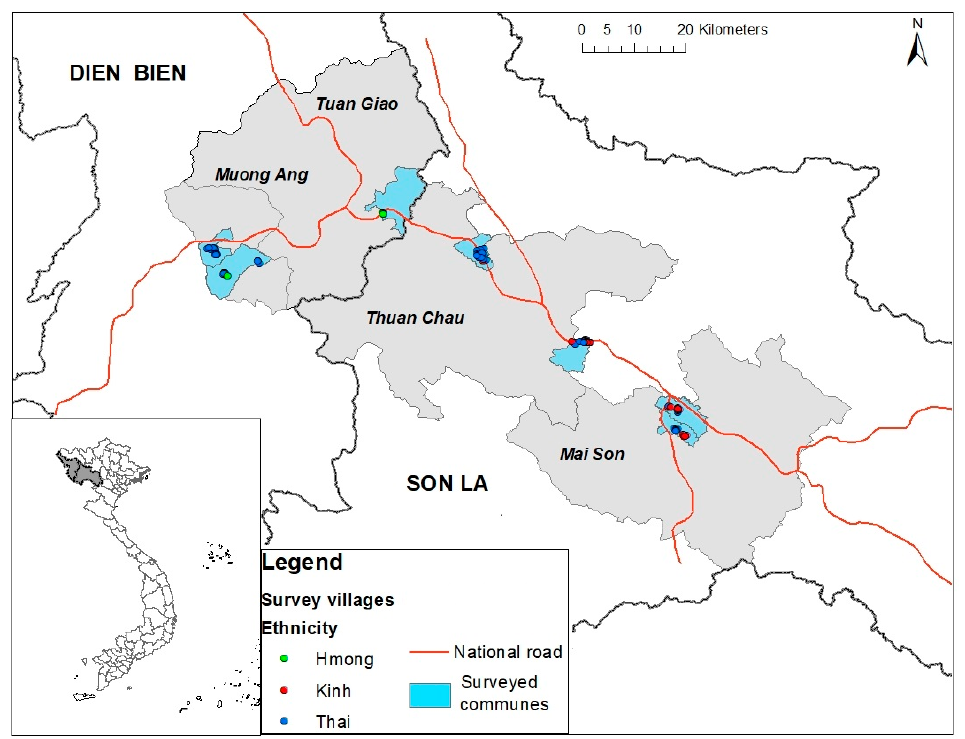
Figure 1. Map of the study sites and the communes surveyed in the Son La and Dien Bien provinces of northwest Vietnam.